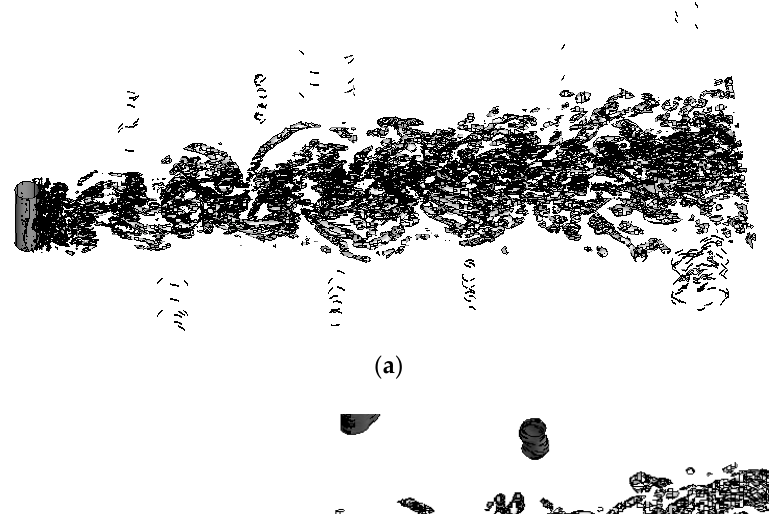
Figure 10. Velocity magnitude contours at Z = 0 plane:( a ) Cylinder; ( b ) PC; ( c ) CP; ( d ) PCP.